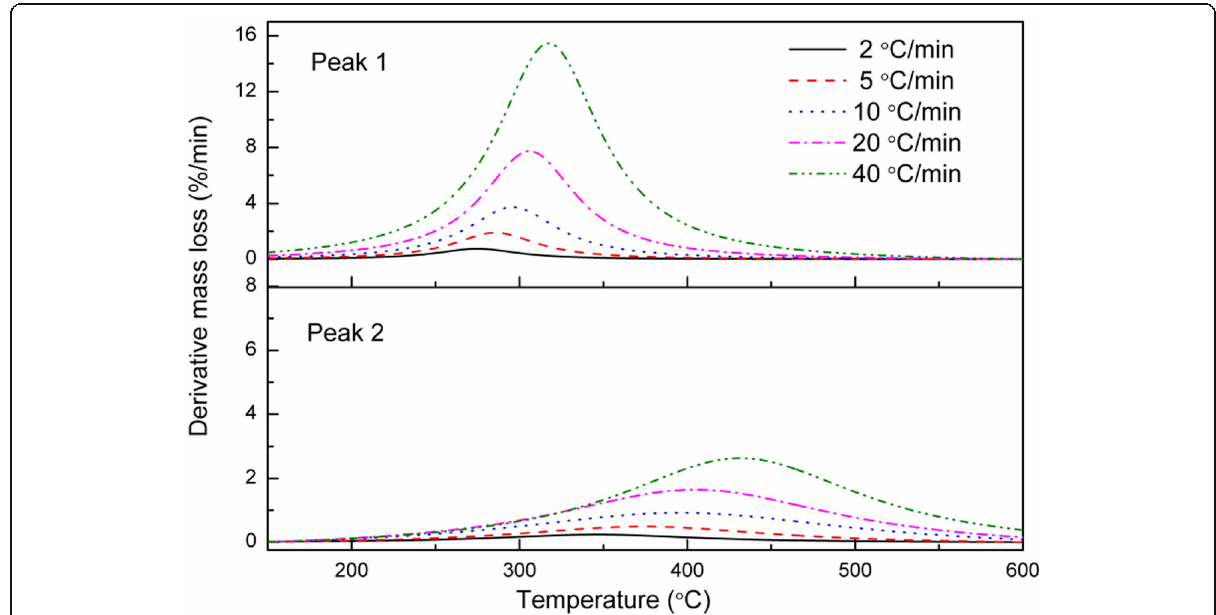
Fig. 4 Sets of peaks obtained by Lorentzian function deconvolution of the DTG corresponding to the first (peak 1, top) and second (peak 2, bottom) degradation process